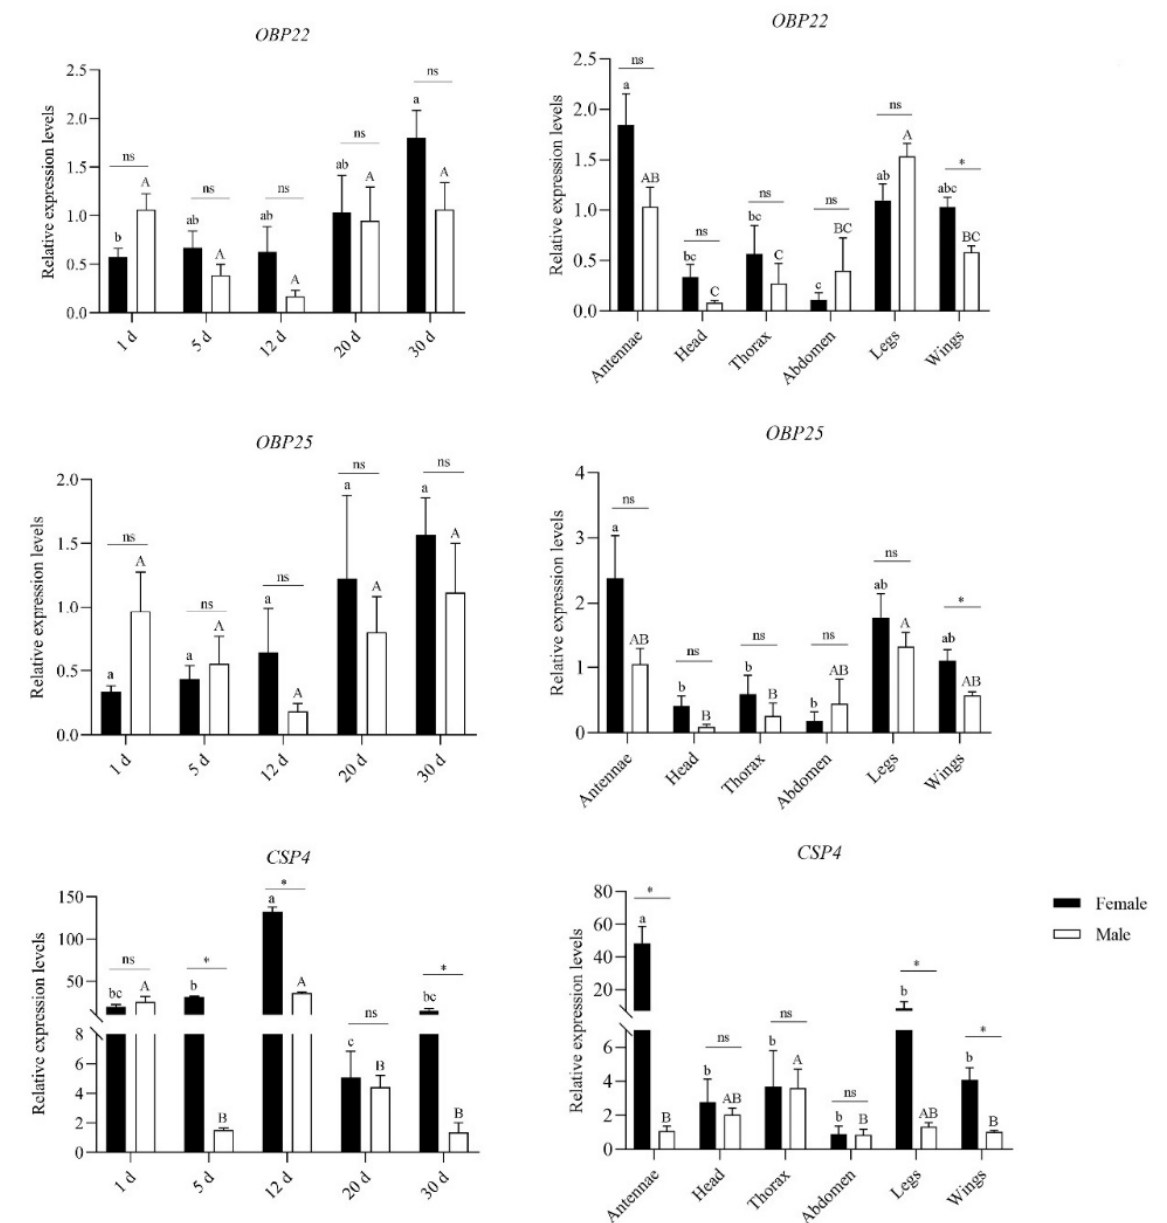
Figure 5. Relative expression levels of OBP22 , OBP25 , and CSP4 of adult Glenea cantor antennae at different ages and of different tissues of 30 d adult. The expression levels were calculated using the 2 −ΔΔ Ct method and the male antennae (30 d) were selected as the calibrator to normalize the gene expression levels in various ages and tissues. The values were shown as means ± SE ( n = 3). Different lowercase letters indicate significant differences between ages or tissues of females and different capital letters indicate significant differences between ages or tissues of males ( p < 0.05, ANOVA). * indicates significant difference between different sexes in the same age or tissue. ns indicates no significant difference.